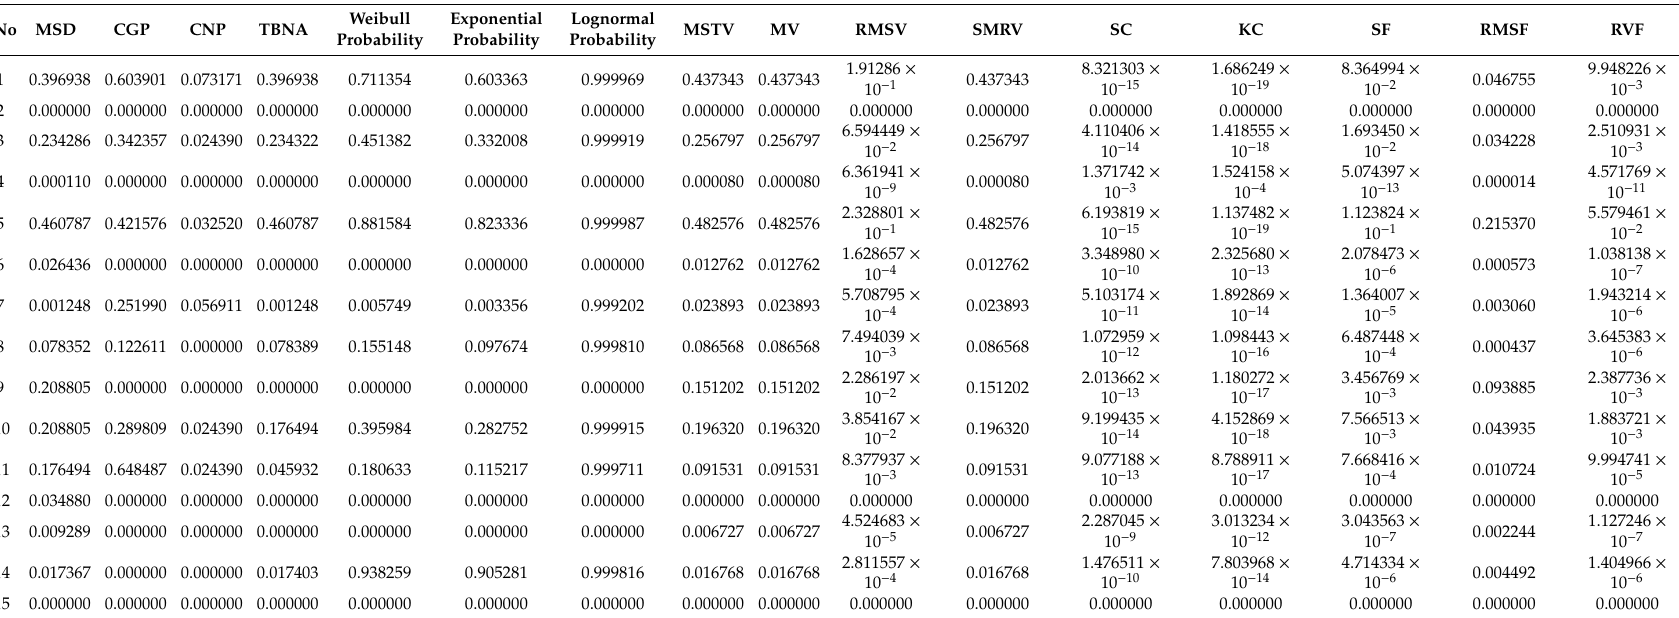
Table 4. Sample training